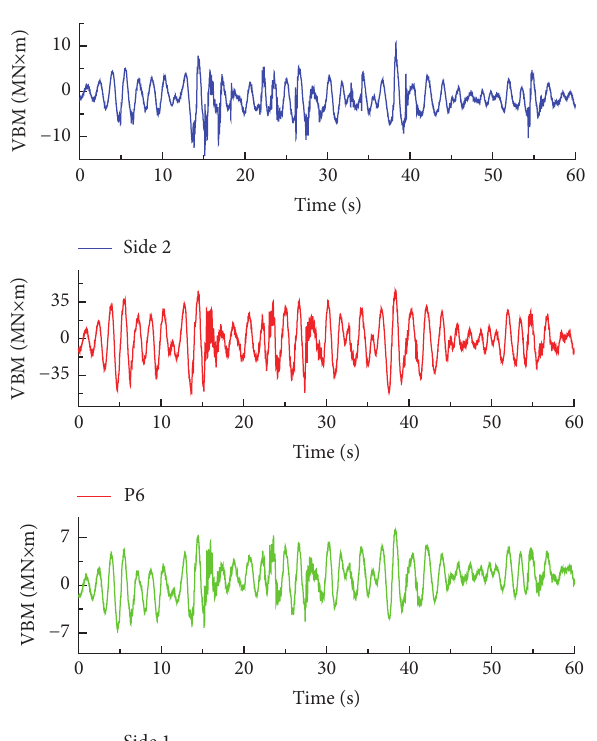
Figure 24: VBM time histories of main and side hull.